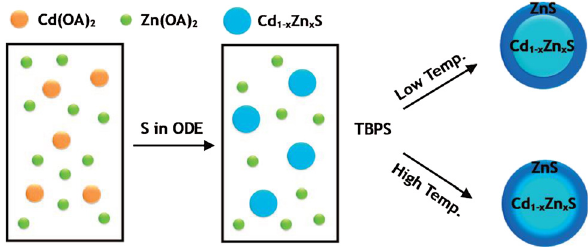
Figure 4: Synthetic scheme and proposed structures of core/shell NCs. Cd 1 − x Zn x S/ZnS core/shell NCs grown at higher temperature (above 250 ° C) after the second injection of S precursor have